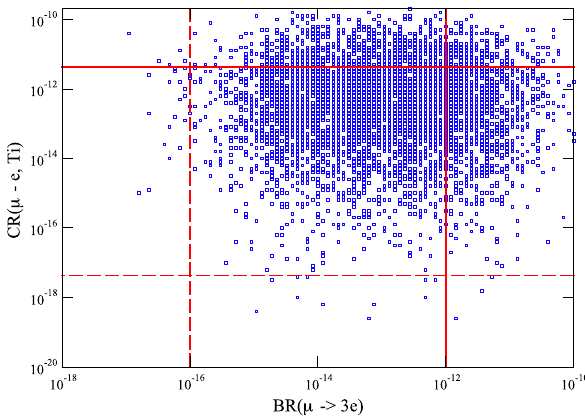
Fig. 9 The correlation between μ → 3 e and μ – e conversion in nuclei for our sample of viable